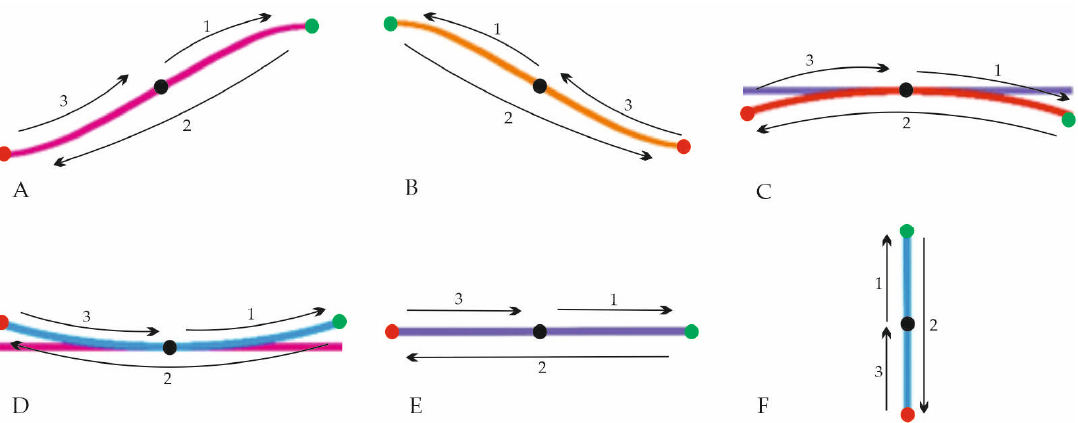
Figure 1. Motion patterns in the VRneck system: ( A )—right arc, ( B )—left arc, ( C )—bottom arc, ( D )—upper arc, ( E )—rotation and ( F )—extension–flexion movement; the direction and order of movements are indicated by arrows. Black dot—starting and ending point, green dot—goal of the first movement, red dot—goal of the second movement.